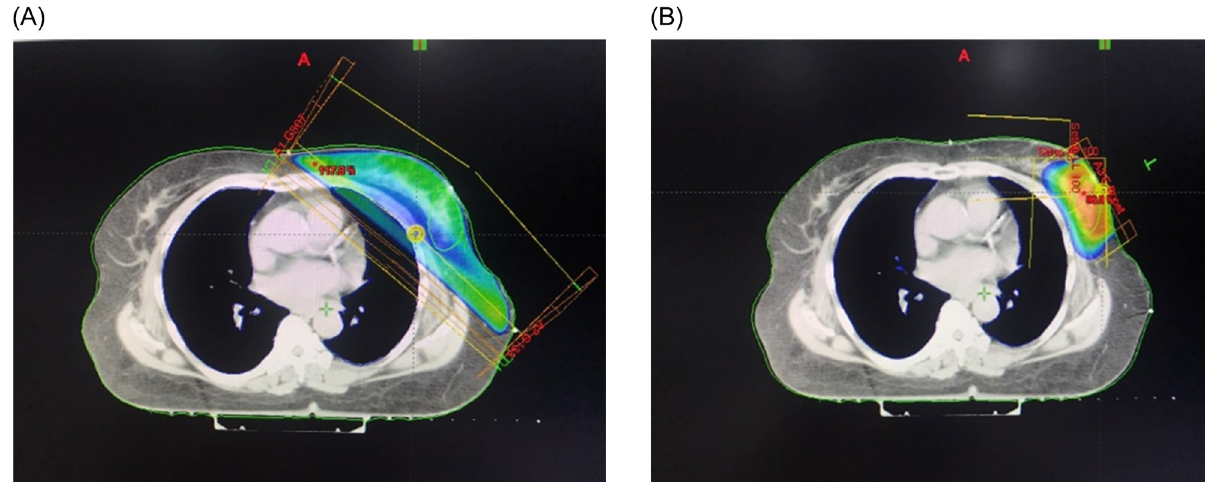
Fig 1. The treatment planning. 1A. Whole breast irradiation. 1B. Electron beam